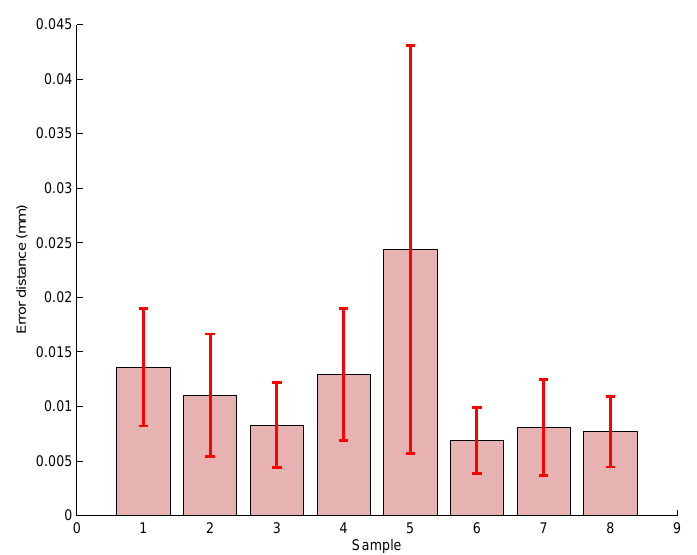
Figure 5. Static point positioning variability. Bar indicate the standard deviation—red whiskers show the variability range.